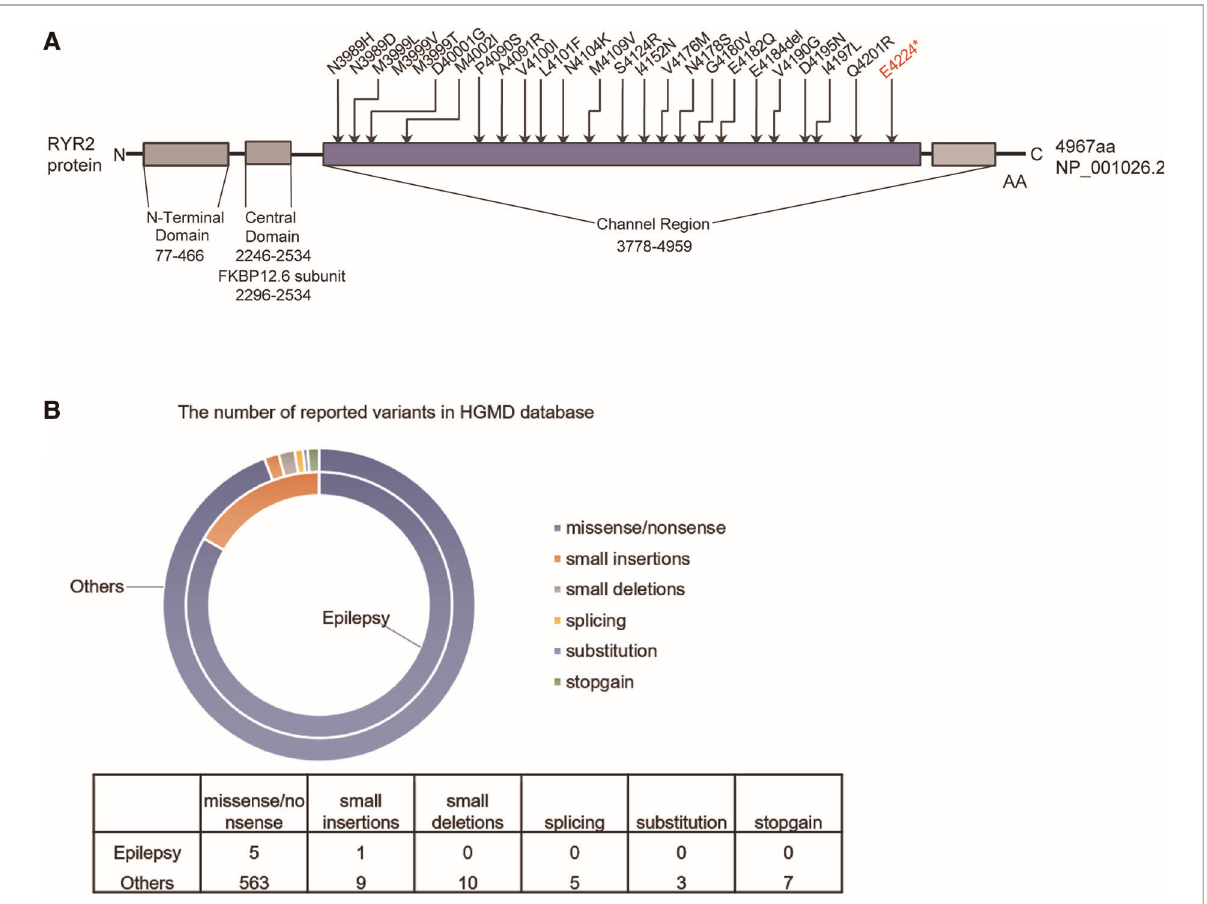
FIGURE 4 The reported RYRA2 variants. ( A ) Schematic diagram of the pathogenic or likely pathogenic mutations presented in the ClinVar database in the exon 90 of the RYR2 gene. ( B ) The number of reported RYR2 variants associated with epilepsy (small deletions, small insertions, splicing, stopgain, and missense/nonsense variants) in the